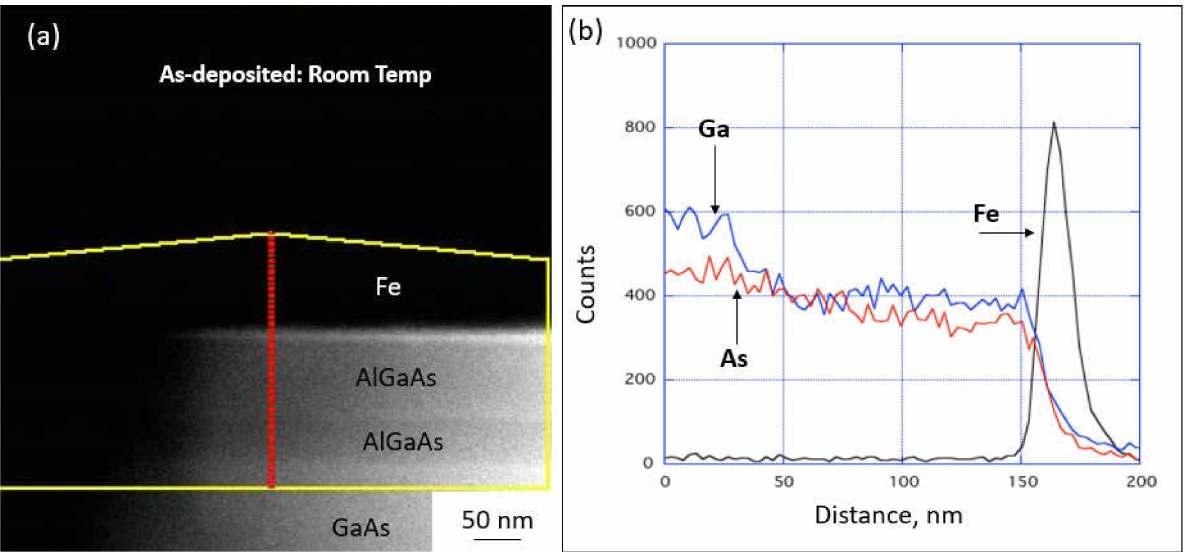
Figure 8. ( a ) An HAADF image of the Fe film deposited at room temperature on AlGaAs/GaAs/ AlGaAs/GaAs(subs) template. ( b ) The corresponding composition line-scan showing no